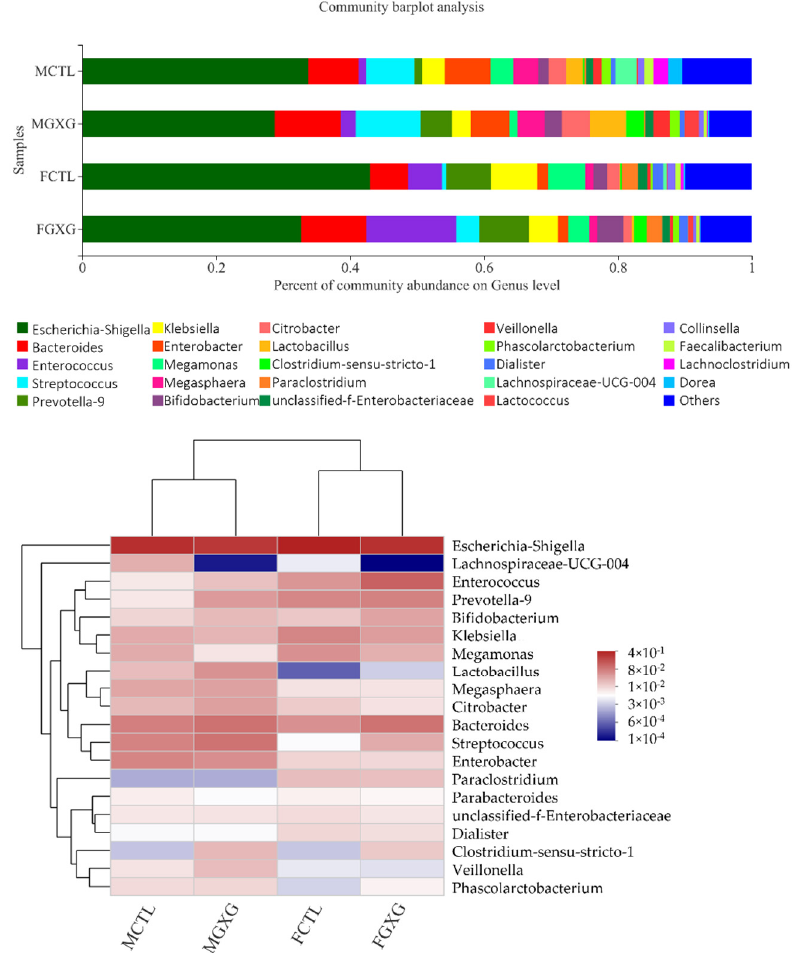
Figure 4. The relative abundance ( up ) and heatmap ( down ) of microbiota, with/without Dendrobium officinale polysaccharide treatment, at the genus level.